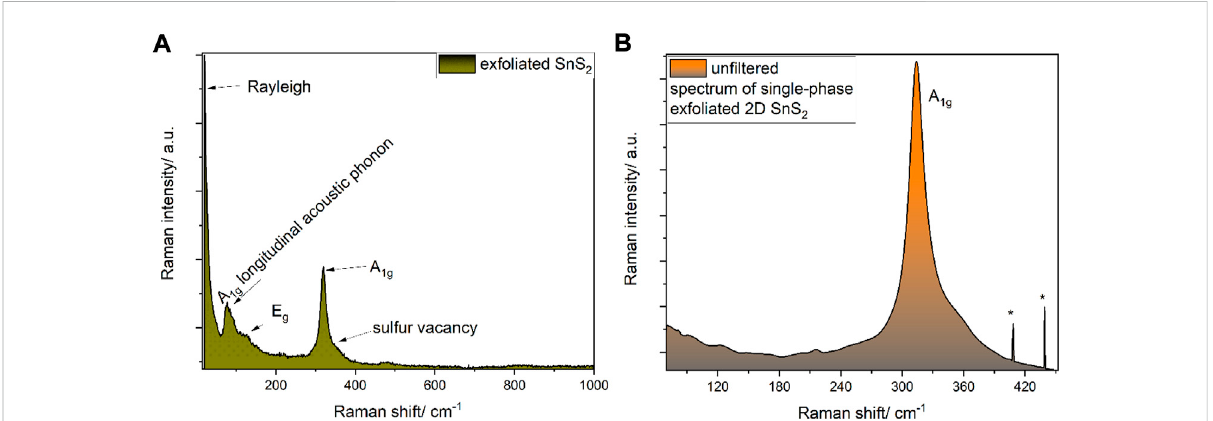
FIGURE 2 (A) Ramanspectrum(633 nm)oftheexfoliatedSnS 2 .Pleasenotethelowpositionofthelongitudinalacousticphonons,whicharelocatedmuch lower than the modes observed during the exfoliation in e.g. Supplementary Figure S7. (B) Raman spectrum (633 nm) of 2D SnS 2 . Asterisks (*) represent cosmic rays signals. The shoulder at around 330 cm − 1 is attributed to a S 2 − vacancy. For detailed analysis see Supplementary Figure S8, as discussed in the